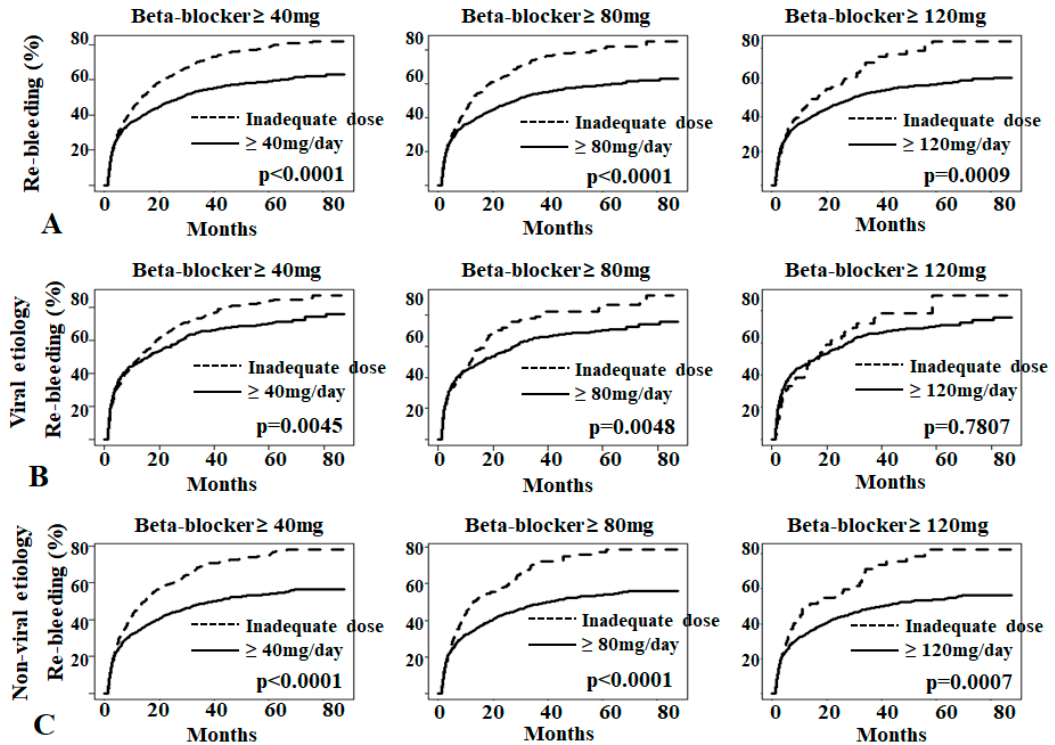
Figure 4. Rebleeding in patients with variceal bleeding and large-volume ascites. ( A ) Varix rebleeding rate due to various dosages of NSBB. ( B ) Varix rebleeding rate due to various dosages of NSBB in patients with viral cirrhosis. ( C ) Varix rebleeding rate due to various dosages of NSBB in patients with non-viral cirrhosis.